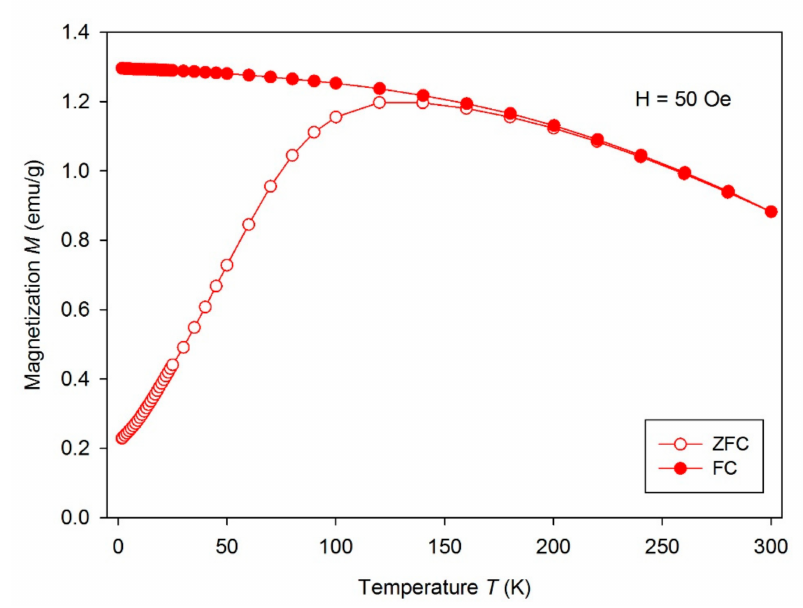
Figure 8. Temperature dependence of magnetization measured for